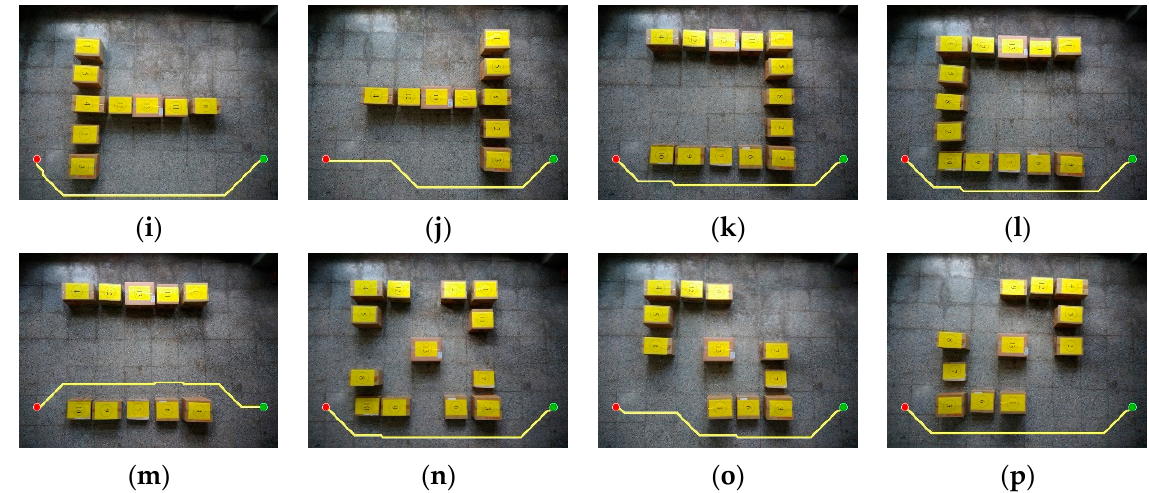
Figure 28. Planned paths shown in Experiment IX: ( a ) result #1; ( b ) result #2; ( c ) result #3; ( d ) result